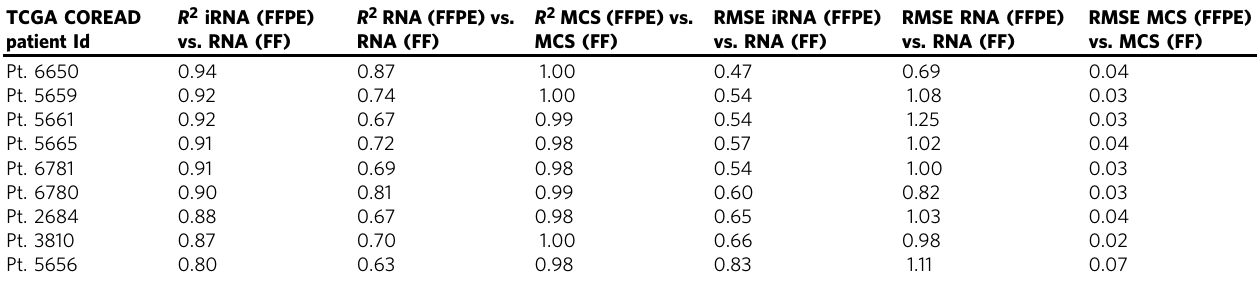
Table 1 R 2 and RMSE for intra-sample correlations between MethCORR inferred RNA expression (iRNA), RNA expression, or MCS in FFPE samples and RNA expression or MCS in matched fresh-frozen